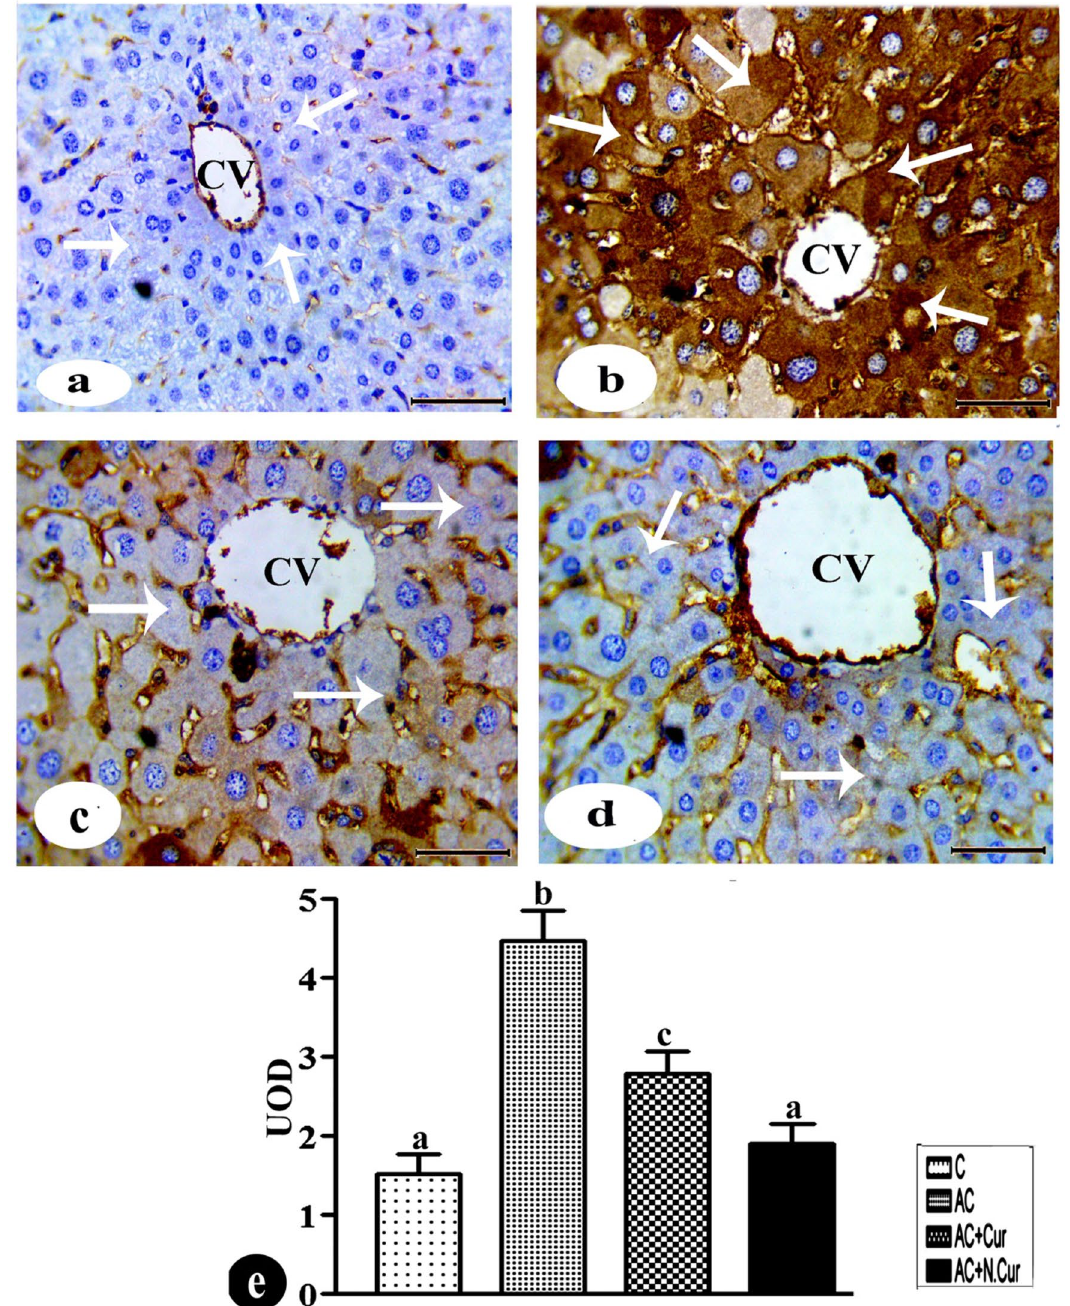
group, and (d) AC + NCur group (negative reaction, arrows). bar = 50 µm. (e) Statistical, values in the column with unlike superscript letter were significantly different ( p <